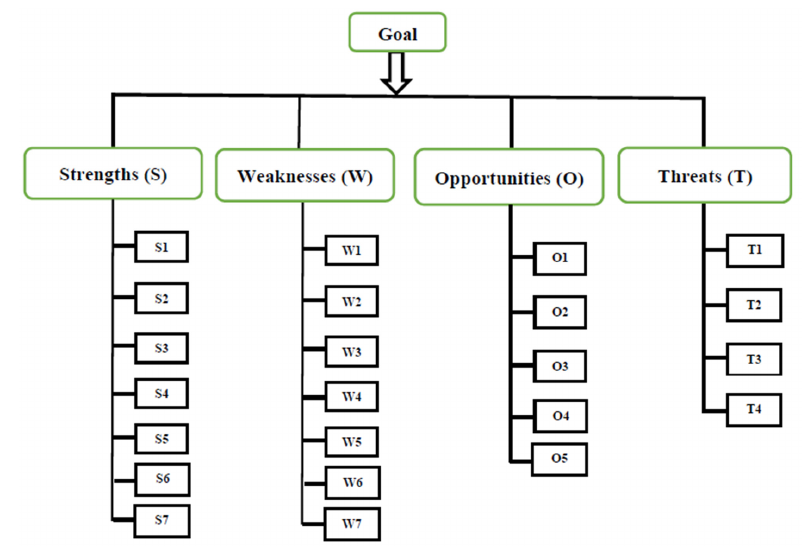
Figure 7. Hierarchical structure of the factors